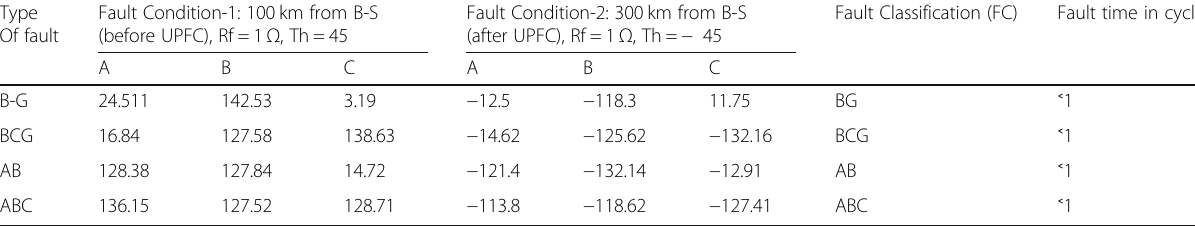
Table 1 DSE of different phase fault, fault classification & detection, fault time (before and after UPFC) Type Of fault